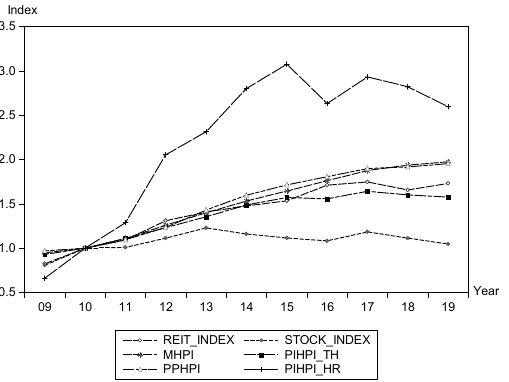
Figure 1. Comparative Analysis of Property Price Indices and Stock Indices (2009–2019). Table 5. Pearson Correlation Coefficient of Investment Assets.